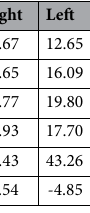
Table 6. Fig. 5-D data measurement.